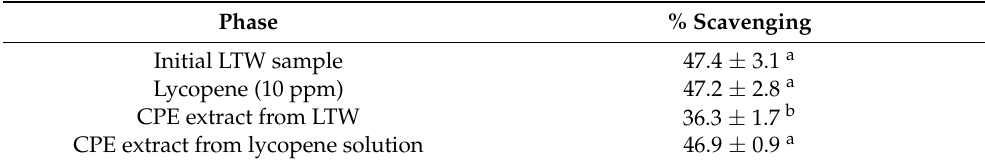
Table 3. Antioxidant activity of the initial LTW sample, a 10-ppm lycopene solution, and the surfactant phases after CPE of the two